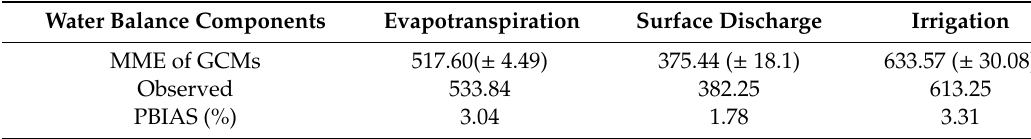
Table 5. Comparison of surface discharge calculated from observed climate data and bias-corrected General Circulation Models (GCMs) data for 1976–2005. Values in parentheses refer to the standard deviation of the results over the